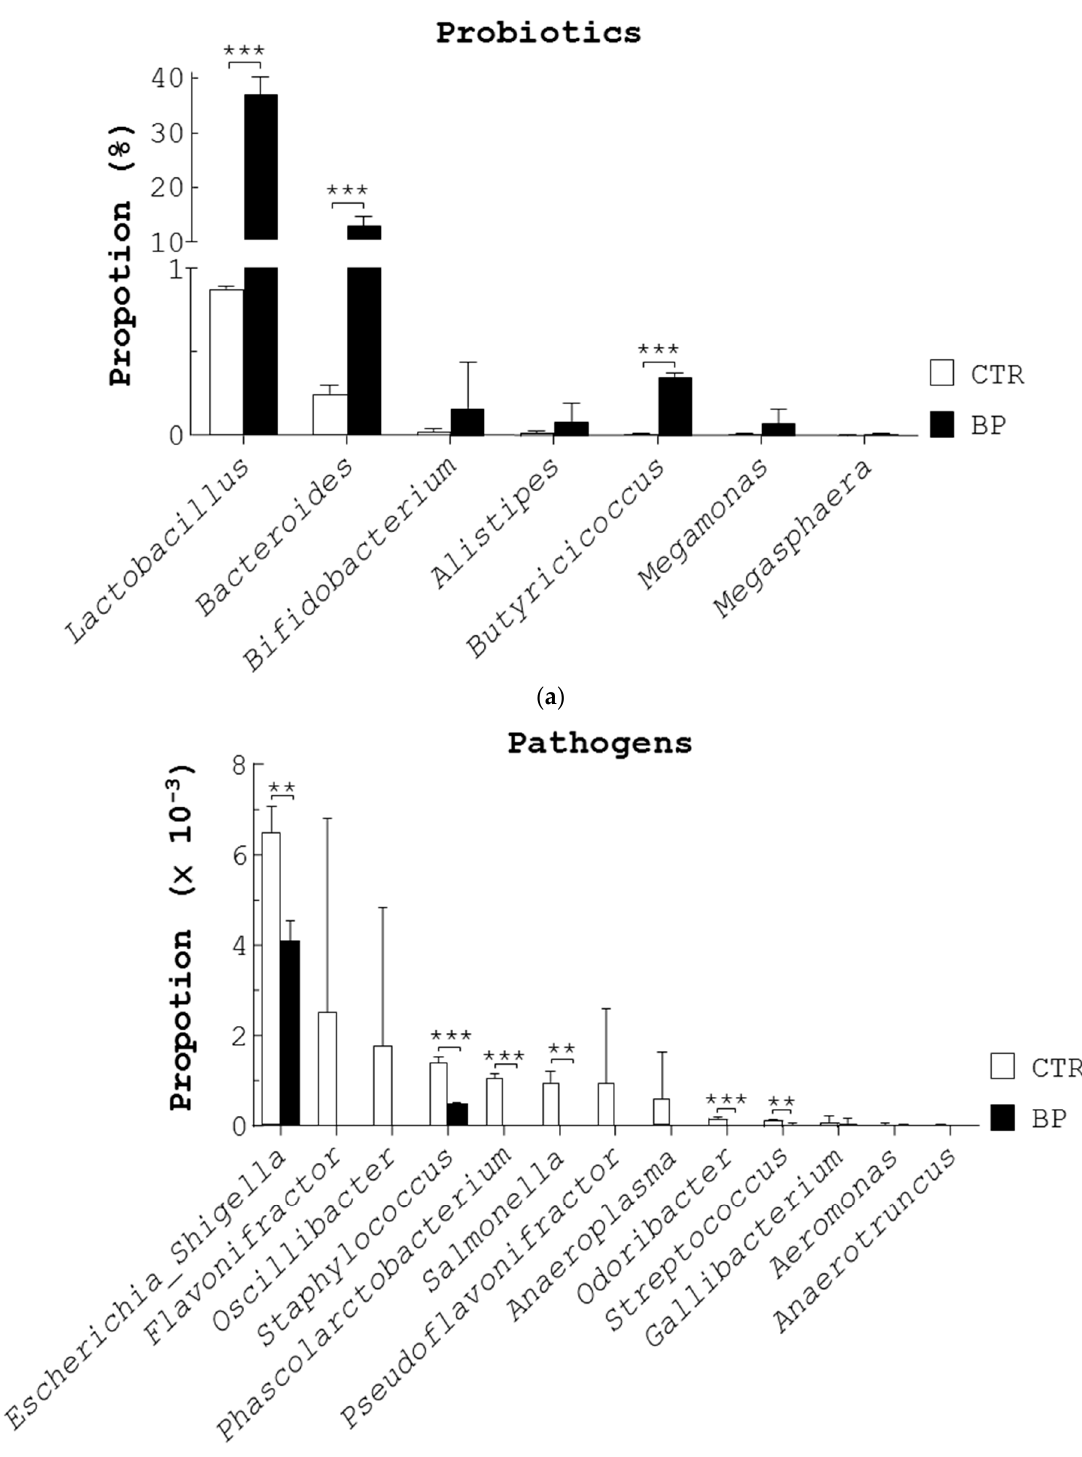
Figure 2. BP increases the 7 probiotic genera and decreases the 13 pathogenic genera. The stools of 54-week-old laying hens (Figure 1c) that were given a standard diet (CTR) and the diet containing 250 ppm BP for 4 weeks were collected to obtain fecal bacteria DNA, followed by bacterial 16S rDNA NGS analysis. The proportion of probiotics ( a ) and pathogens ( b ) of the fecal microbiota were analyzed at the genus level. Data from 3 repeats are presented as the mean ± SD. One-way ANOVA test was used for statistical analysis of differences between groups and p (**) < 0.01 and p (***) < 0.001 are considered statistically significant.